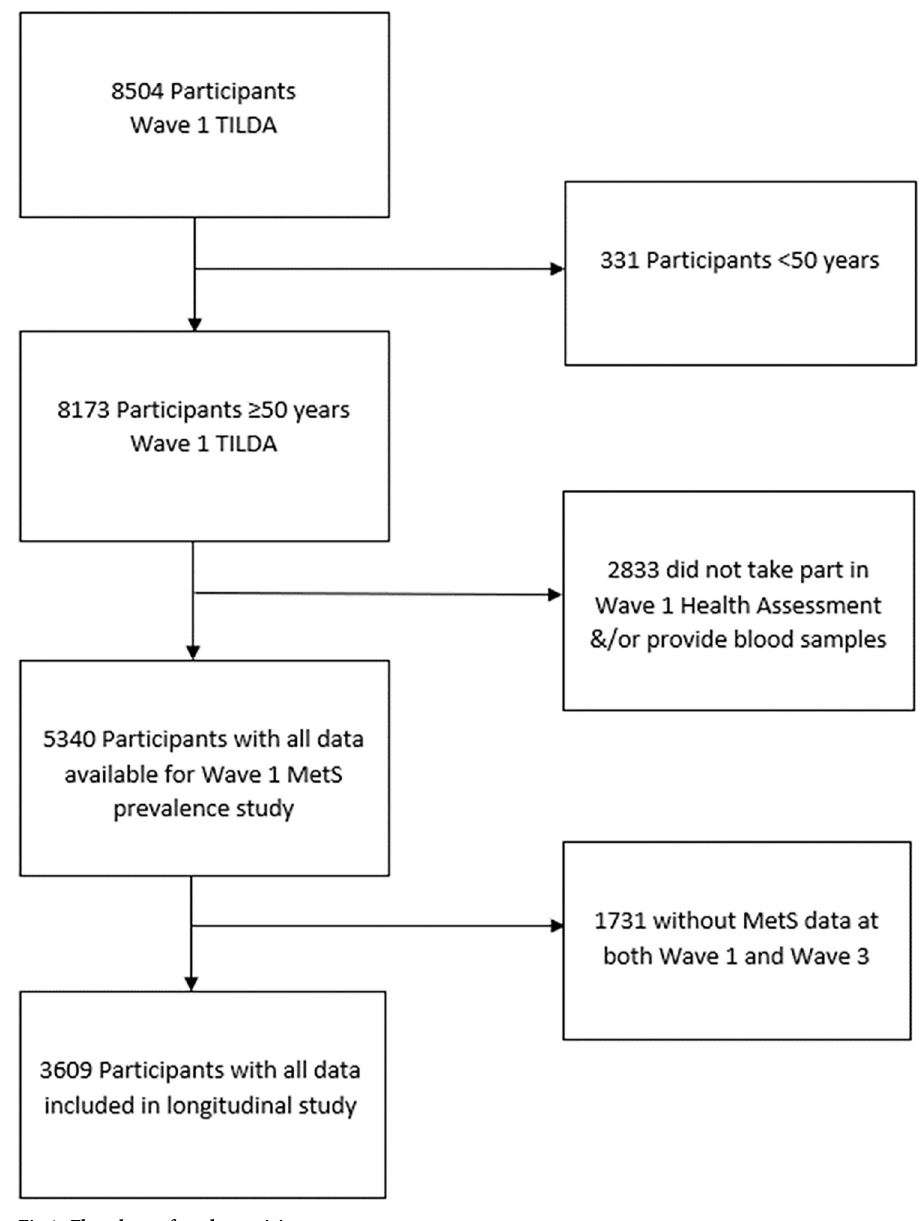
Fig 1. Flowchart of study